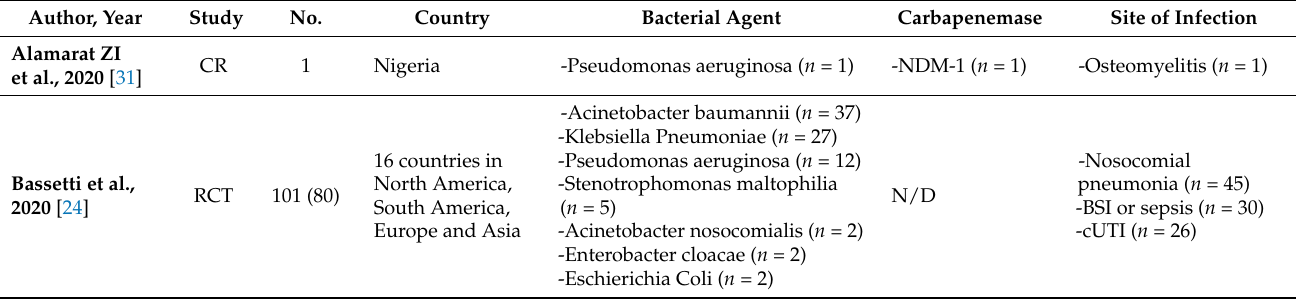
Table 2. Case reports of CR bacteria